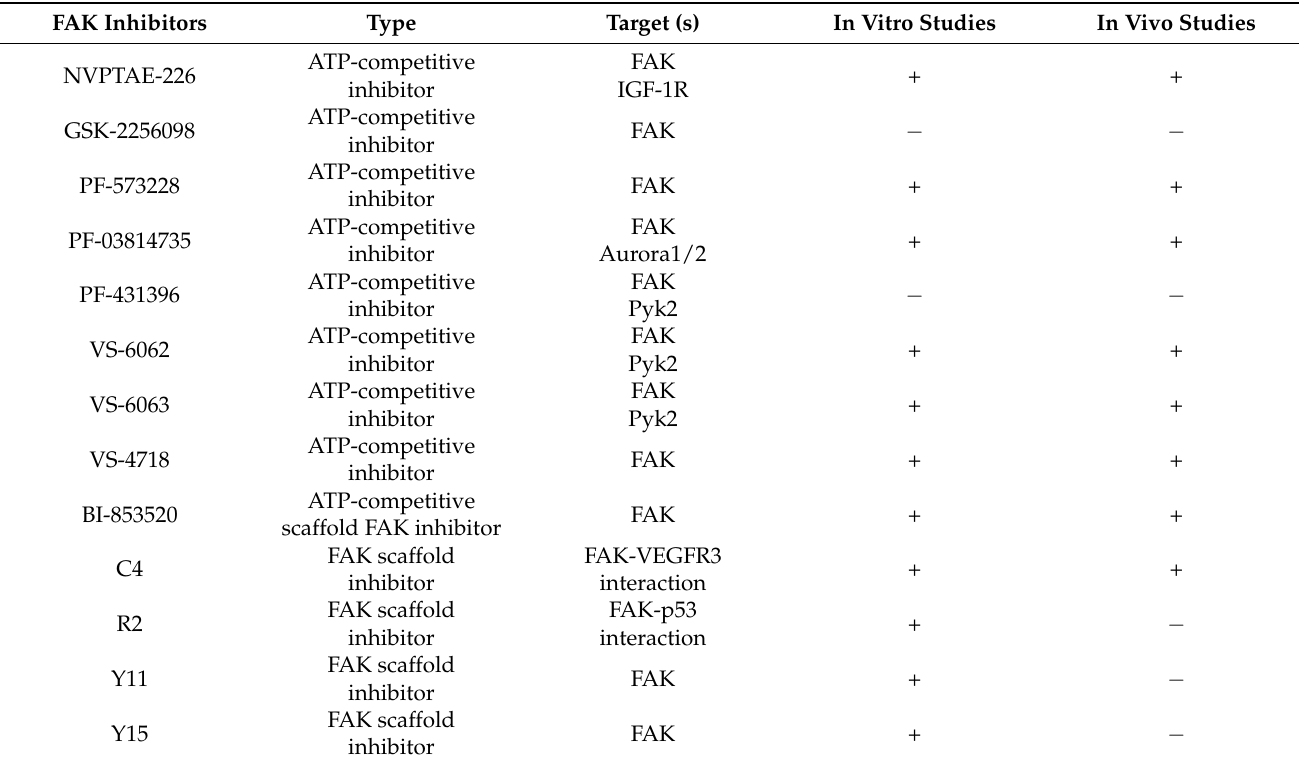
Table 1. FAK inhibitors tested for their anti-cancer action in breast tumor models both in vitro and in vivo. FAK Inhibitors Type Target (s) In Vitro Studies In Vivo Studies FAK + NVPTAE-226 inhibitor IGF-1R